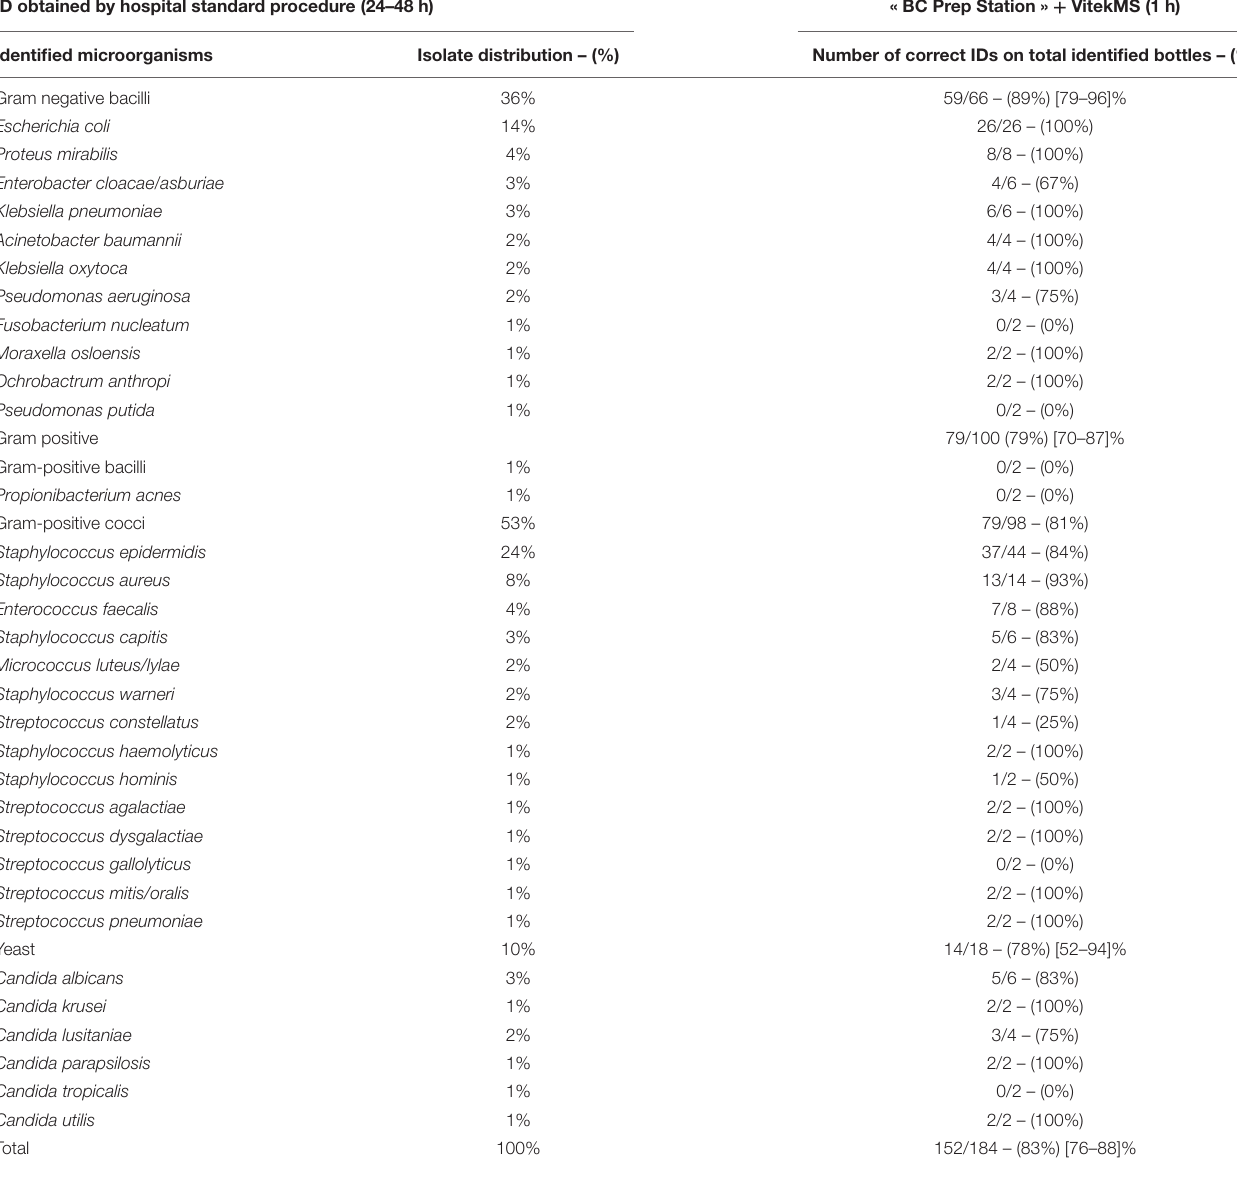
TABLE 2 | Direct identification versus standard procedure from clinical blood cultures (BCs) in routine practice: Gram-negative bacteria, Gram-positive, and yeast. ID obtained by hospital standard procedure (24–48